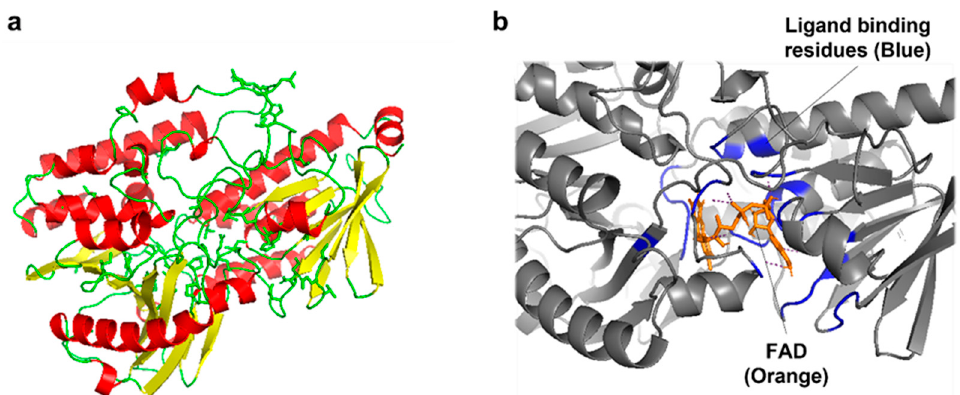
Figure 4. The in-silico-predicted structure of CrtI RS ( a ) and partial view of molecular docking with FAD ( b ). The FAD ligand binding residues are shown in blue and FAD is shown in orange.